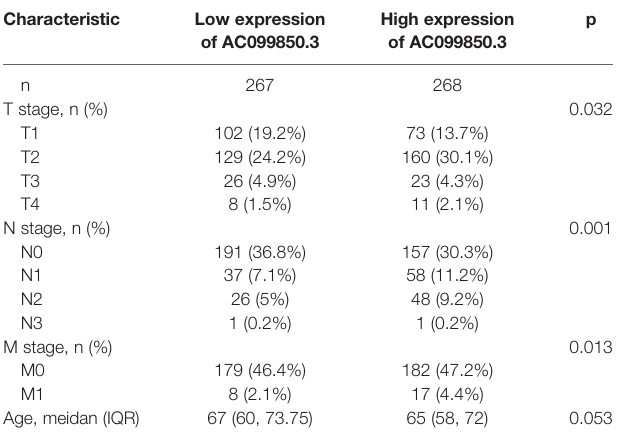
TABLE 1 | Correlation between AC099850.3 expression and clinicopathologic features in the TCGA-LUAD cohort. Characteristic Low expression High expression of AC099850.3 of